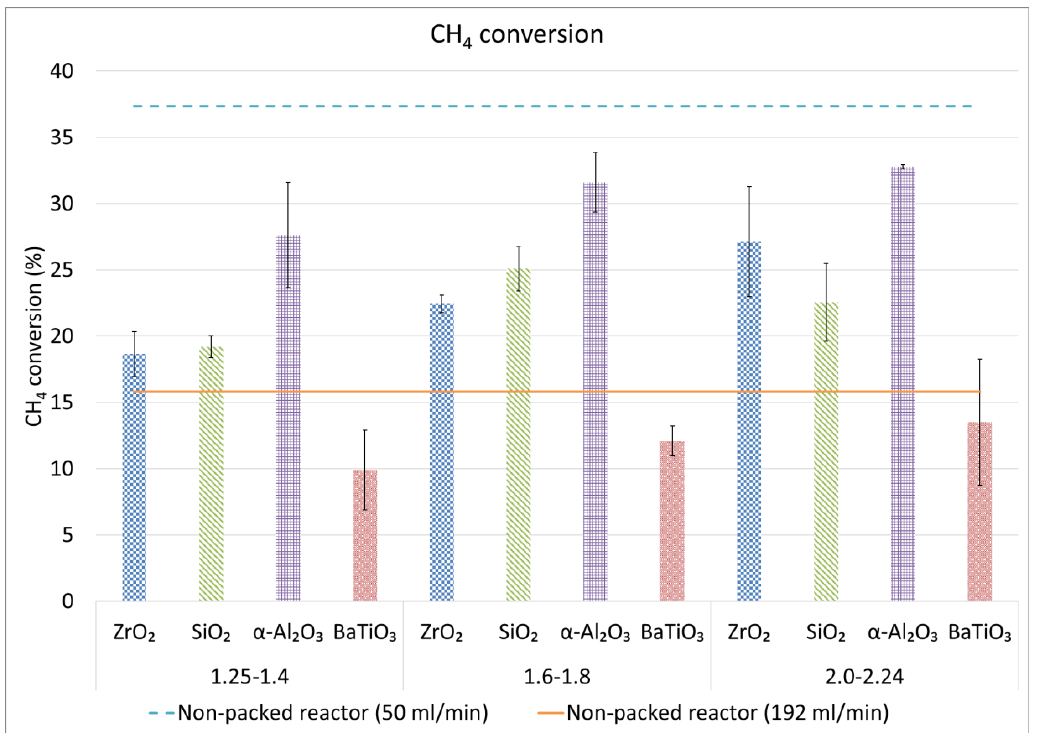
Figure 2. CH 4 conversion for different sphere sizes and materials, compared to the results for the non-packed reactor, at the same flow rate (50 mL/min) and at the same residence time (5.52 s; flow rate of 192 mL/min). Table 3. Ratio of CH 4 conversion over CO 2 conversion and of the CO over H 2 product fraction, for the different sphere sizes and materials, as well as for the non-packed reactor.